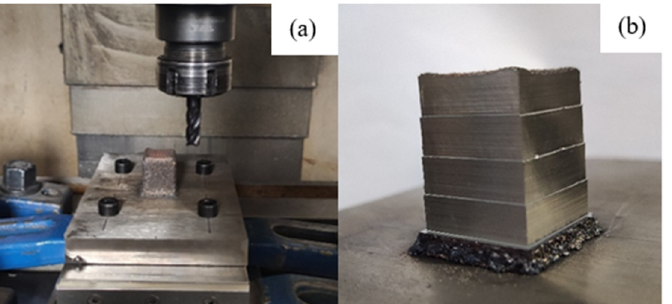
19 of 25 Figure 18. Side milling and force measurement of laser cladding thin-walled parts: ( a ) milling force measurement system; ( b ) GM-4E end mill; ( c ) thin-walled parts after milling; and ( d ) KISTLER tri- axial dynamometer. 4.1.2. Experiment Results and Analysis After filtering and denoising the data measured by the dynamometer, the three di- rectional forces were calculated as F x = 382.927 N, F y = 198.4 N, and F z = 53.422 N, respec- tively. The surface roughness of the thin-walled parts after milling was randomly sampled by a hand-held surface roughness measuring instrument, and the measurement results showed that the minimum surface roughness reached Ra = 0.320 ± 0.1 μ m, indicating that the surface quality of the laser cladding thin-walled parts was significantly improved after milling. 4.2. Side Milling Orthogonal Test of Block Specimens Manufactured by AM For thin-walled parts, the proportion of side milling should be more significant than that of end milling in the actual machining process due to the feature of ASHM. According to the simulation results and the actual AM process of thin-walled parts showed the mor- phology of wide at the top and narrow at the bottom, dynamic compensation of cutting force is needed to obtain high dimensional accuracy of thin-walled parts after milling. As